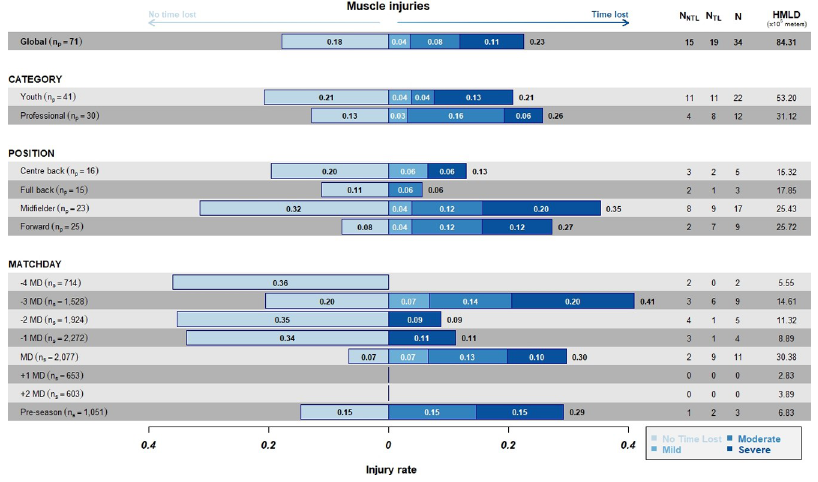
Fig 4. Incidence of TL and NTL injuries per 10 5 m of high metabolic load distance stratified by category, position, and days to/from the match. Numbers inside bars represent the incidence according to the severity.